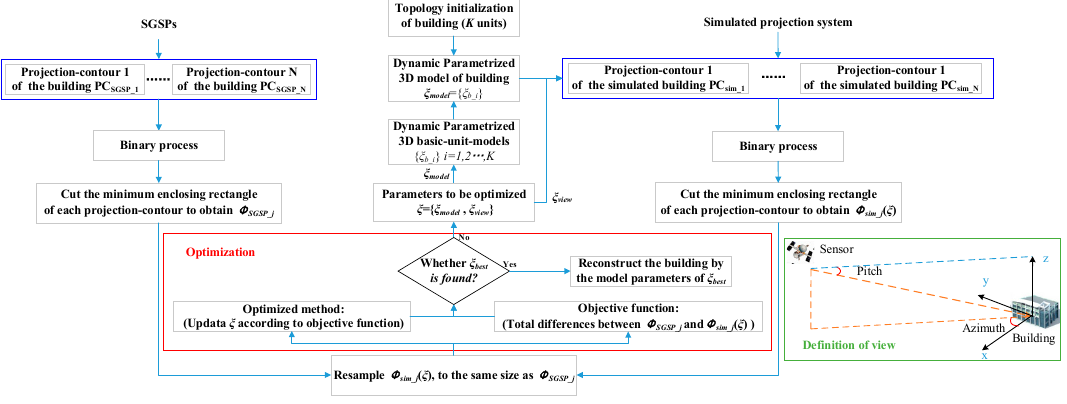
Figure 1. The 3D reconstruction of a building based on a framework of dynamic multi-projection-contour approximating.